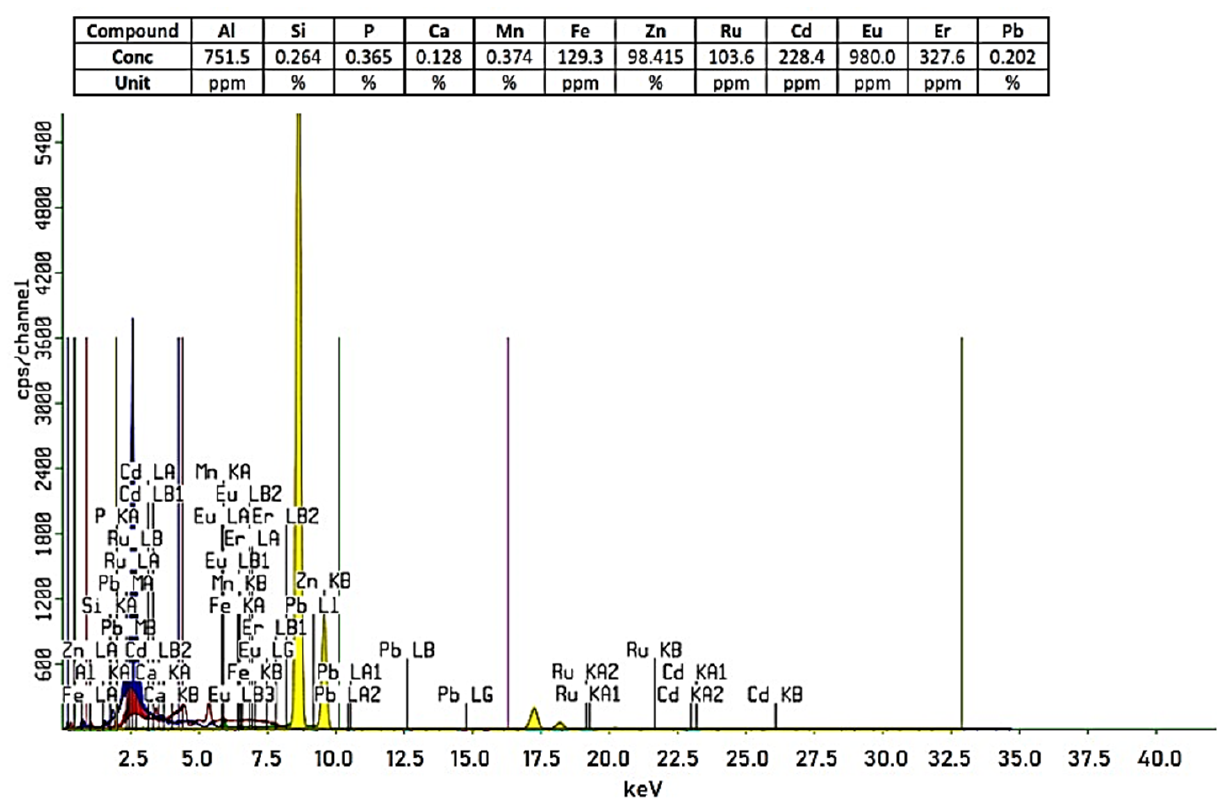
Figure 2. Chemical composition of ZnO from XRF analysis.